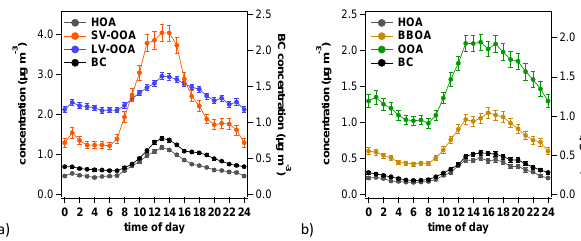
Figure 9. Average daily patterns of the organic-source contributions and BC concentrations for (a) summer and (b) winter. Error bars represent standard